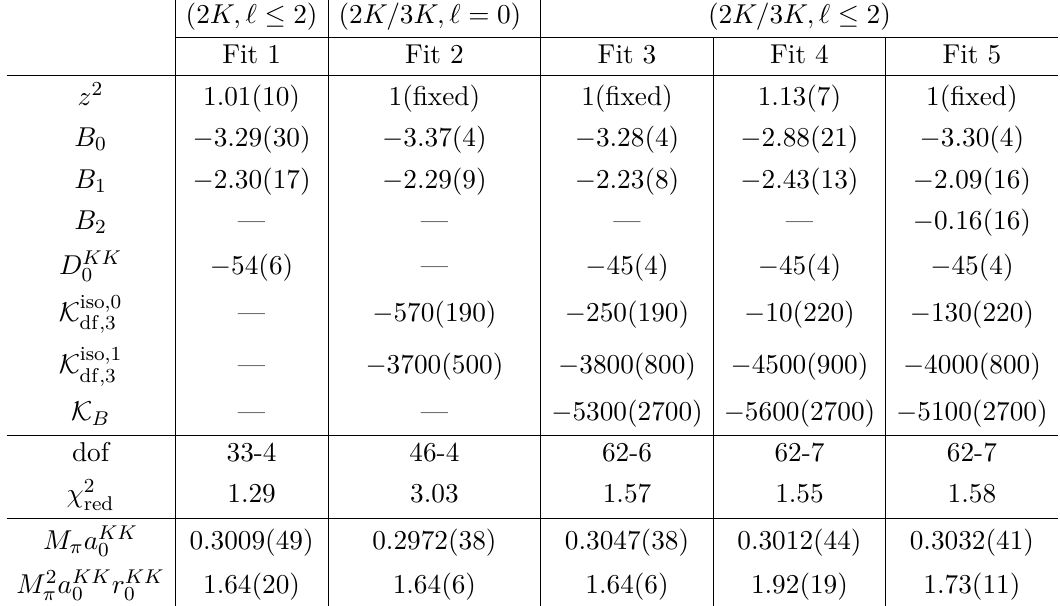
Table 9. Fit results for kaons on the N203 ensemble with M K L = 6 . 908149 , using the Adler-zero form for the s -wave phase shift. Each fit contains all 2 K + and 3 K + energy levels (in the appropriate irreps) below E ∗ = 2 . 9 M K and E ∗ = 3 . 9 M K , respectively, except that we only include the max 2 , max lowest 2 K + level in the A 1 irrep in the d 2 = 9 frame, as the two higher-energy levels have unusually large